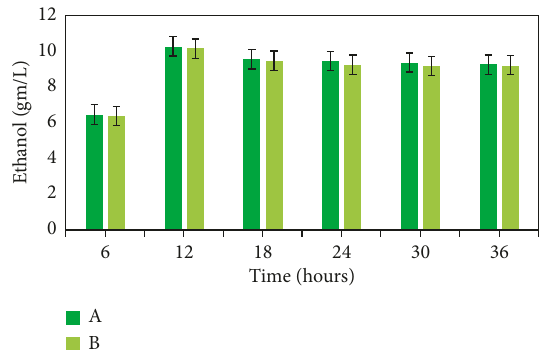
Figure 10: Ethanol production after (a) first and (b) second rounds of immobilized E. coli